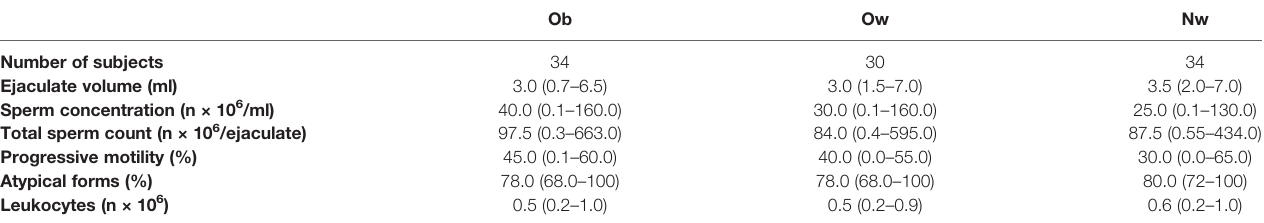
TABLE 2 | Semen parameters in obese, over weight, and normal weight subjects.